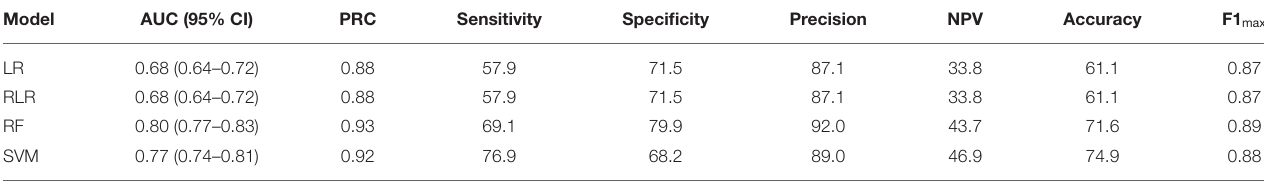
TABLE 3 | Scores for each algorithm of model 1 in derivation cohort.